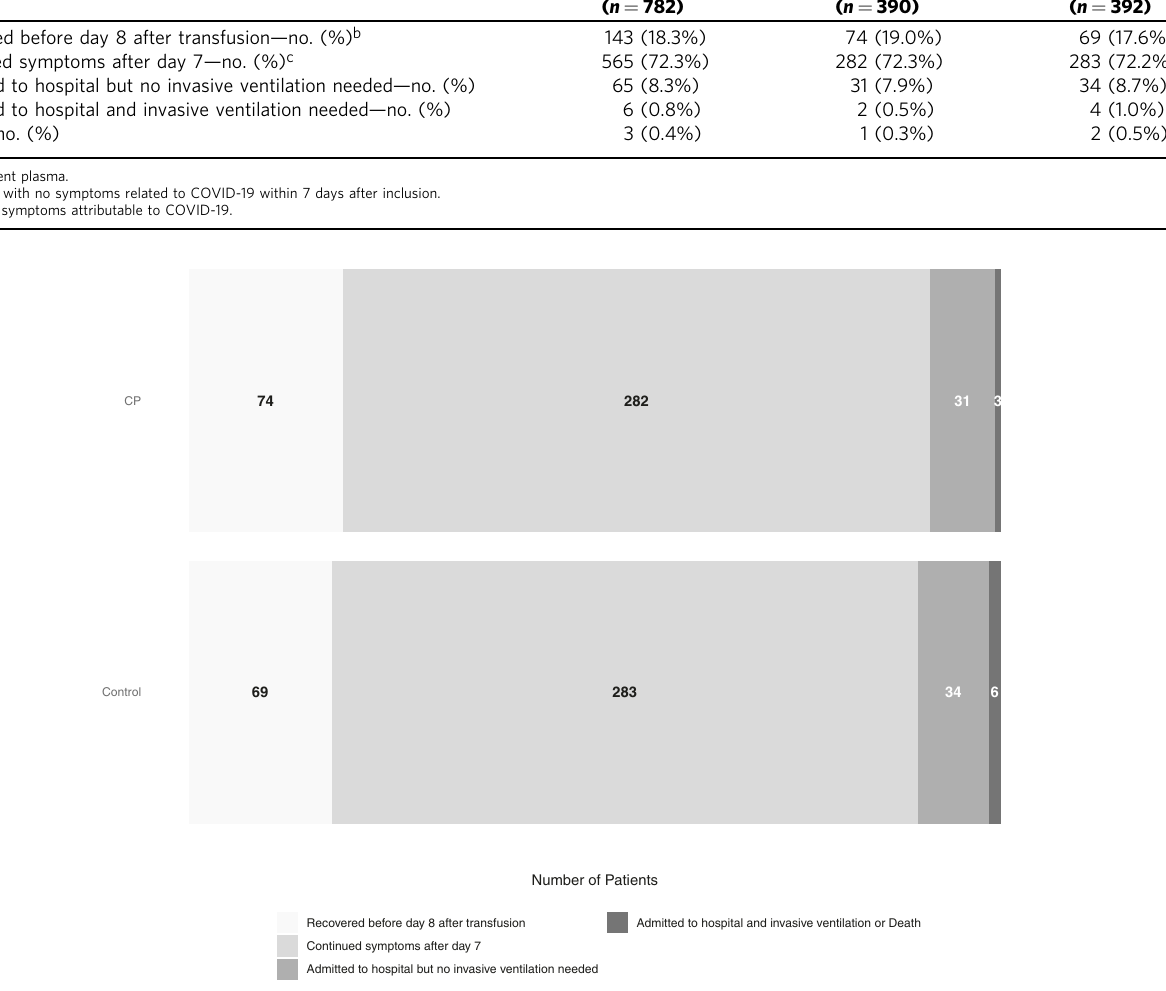
Table 2 Distribution of the outcome of the patients in the 28 days after inclusion across the 5-points disease severity scale. Worst disease severity score